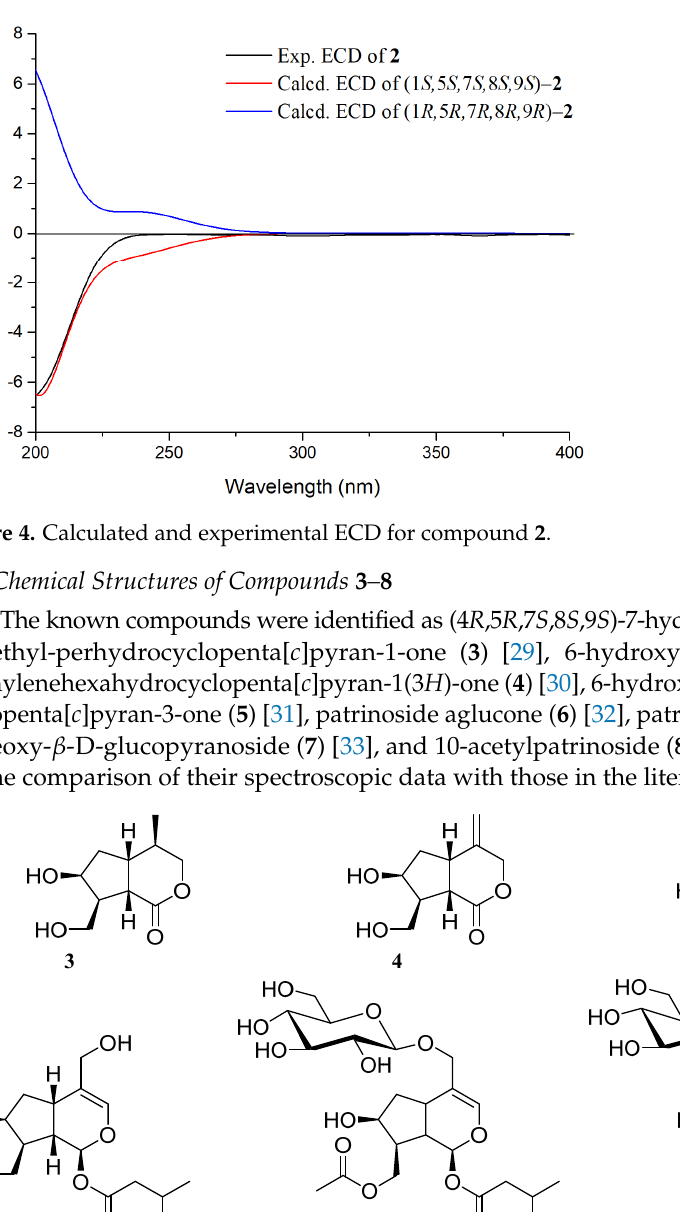
Figure 3. Key 1 H- 1 H COSY, HMBC, and ROESY correlations for compound 2 .